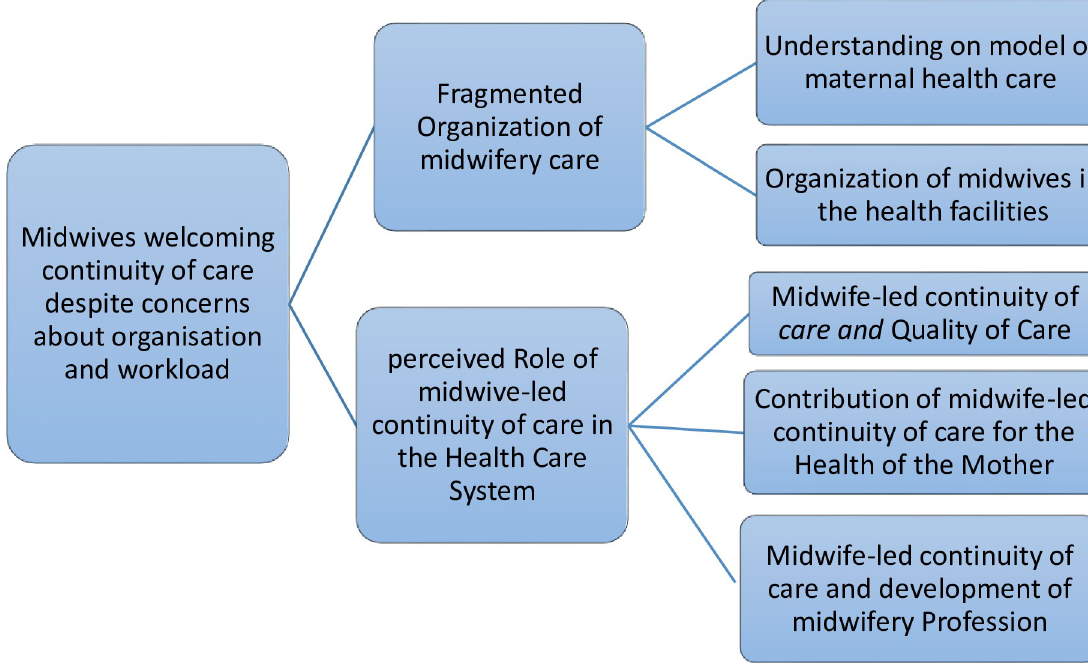
Fig 1. Main theme, themes and subthemes identified in the analysis